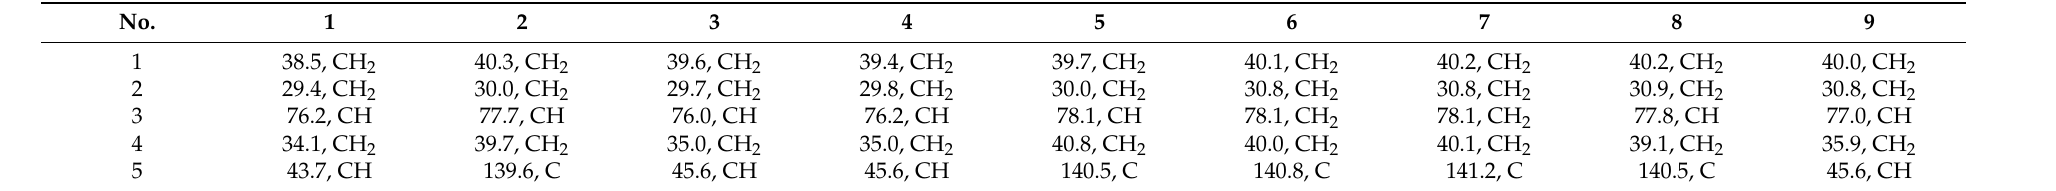
Table 3. 13 C NMR Data of Compounds 1 − 9 (150 MHz, δ H in ppm, J in Hz, pyridine- d 5